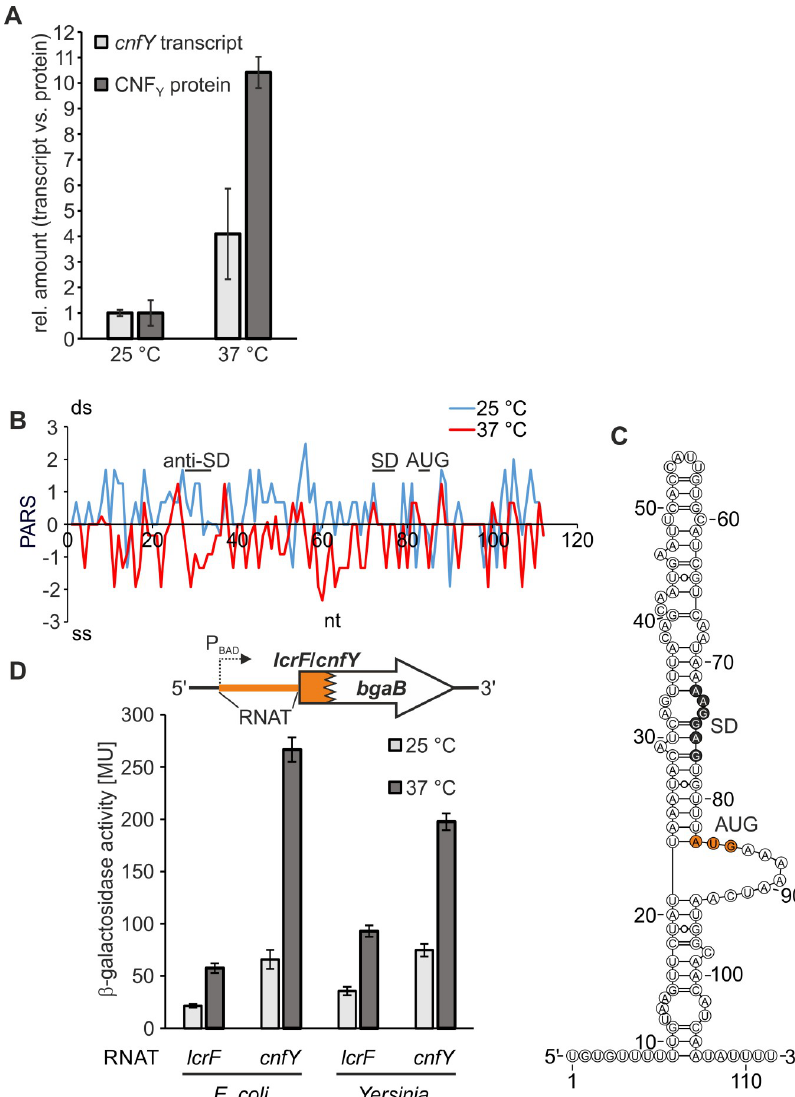
Fig 1. The cnfY 5’-UTR comprises a temperature-sensitive regulatory RNA element. (A) Comparison of cnfY transcript and CNF Y protein levels at 25˚C and 37˚C. Y . pseudotuberculosis YPIII was grown to exponential growth phase (OD 600 = 0.5) at 25˚C or 37˚C and samples were harvested for subsequent qRT-PCR and Western blot analysis. Temperature-dependent transcription was measured by qRT-PCR. Data were analyzed by the ΔΔ Ct method [30] and cnfY transcription was normalized to that of reference genes nuoB and gyrB . Amounts of cnfY transcript relative to levels detected at 25˚C are shown. CNF Y signals from Western blot analysis were quantified by integrated density quantification using AlphaEaseFC software. The mean density values and standard deviations from three independent experiments were calculated and normalized by the respective mean density value measured at 25˚C. A representative Western blot is displayed in S1A Fig. (B) PARS profiles of the cnfY RNAT (-82 nt to +30 nt from AUG) at 25˚C and 37˚C. The potential SD sequence, its pairing sequence (anti-SD), and the AUG are marked. (C) PARS-derived secondary structure of cnfY (-82 nt to +30 nt from AUG) at 25˚C [18]. The potential SD region and the translation start codon (AUG) are highlighted in black and orange, respectively. (D) The RNA control element in the cnfY 5’-UTR confers temperature-dependent reporter gene expression. To test for temperature-dependent translational control, the cnfY RNAT was translationally fused to bgaB under control of the P BAD promoter (pBO3192). The yscW - lcrF intercistronic region ( lcrF RNAT) served as positive control (pBO3146). A schematic representation of the reporter gene fusions is displayed. E . coli DH5 α and Y . pseudotuberculosis YPIII cells harboring the corresponding plasmid (technical triplicates per each construct) were grown to an OD 600 = 0.5 at 25˚C. Afterwards, transcription was induced with 0.01% (w/v) ( E . coli ) or 0.1% (w/v) ( Y . pseudotuberculosis ) L-arabinose, respectively. The cultures were split immediately: One half remained at 25˚C while the other was transferred into pre-warmed flasks at 37˚C. After 30 min incubation, samples were taken for subsequent β -galactosidase assay. The displayed results represent the